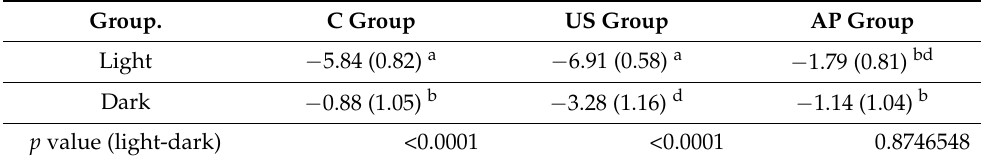
Figure 2. TP values in the studied groups before and after immersion in coffee. Table 2. Mean translucency (TP) values (standard deviation) of the tested specimens at baseline and after immersion in coffee solution. Table 3. Mean translucency difference ( ∆ TP) values (standard deviation) of the tested specimens at baseline and after immersion in coffee